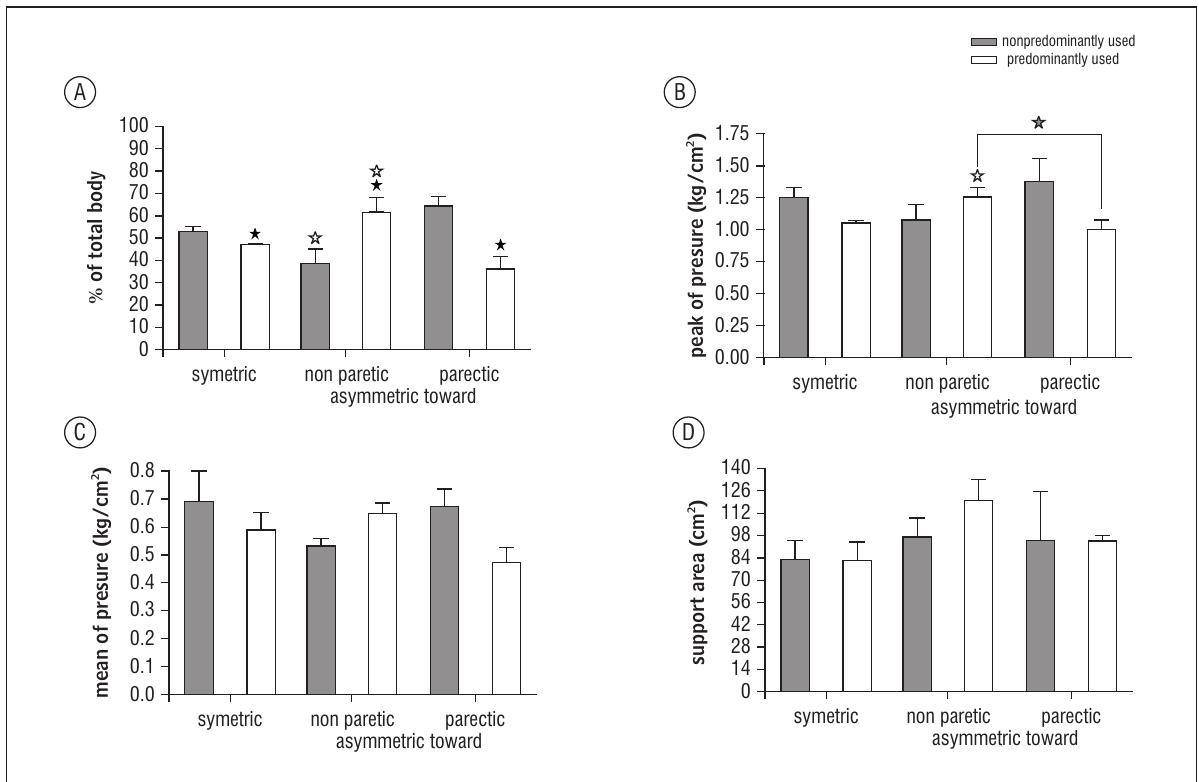
Figure 1 - Bars graphs showing baropodometric parameters (mean ± SEM) under non-predominantly (gray bars) and predominantly (white bars) foot used for hemiparesis group classified by weight-bearing distribution type (sym- metric, asymmetric toward non-paretic side and asymmetric toward paretic side). Baropodometric parameters are indicated by weight-bearing in percentage of the total body (A), peak of pressure in kg/cm 2 (B), mean of pressure under the foot in kg/cm 2 (C), and support area under the foot in cm2. Significant differences between non-predominantly and predominantly foot were indicated by black stars. Differences between types of weight- -bearing distributions when compared with symmetric were indicated by white stars, and when compared with asymmetric types were indicated by gray